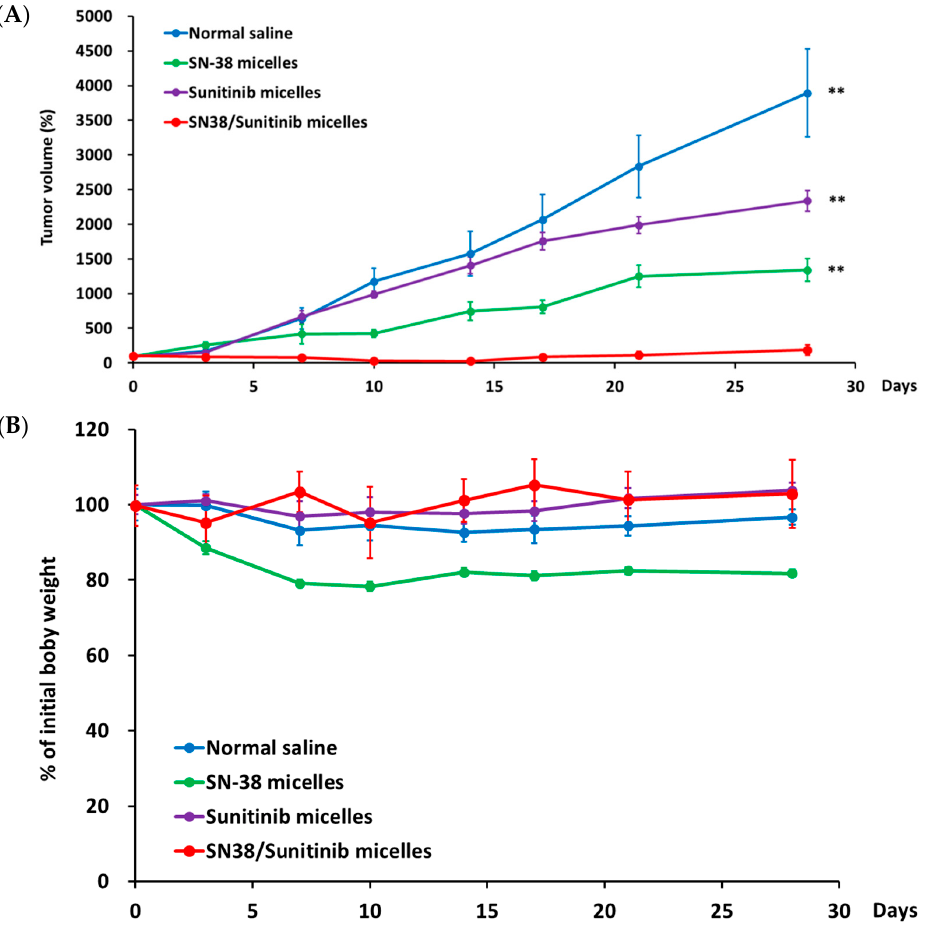
Figure 6. The tumor volume (%) ( A ) and body wight ( B ) of SN-38/Sunitinib micelles in HCT-116 tumor bearing mice. The antitumor efficacy of mediated by normal saline, SN-38 micelles, Sunitinib micelles, or SN-38/Sunitinib micelles in mice bearing HCT-116 tumors. All data are mean ± standard error. ** means significantly different at p < 0.01, compared with SN-38/Sunitinib